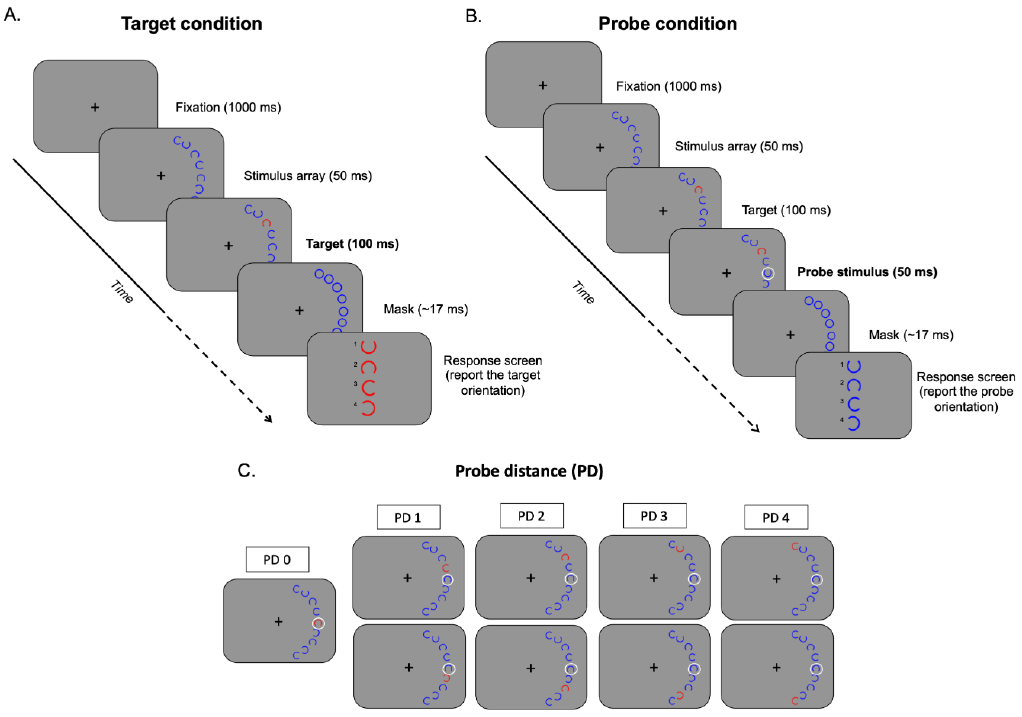
Figure 1. Schematic representation of the task procedure used to measure the spatial profile of the attentional focus in SSD. ( A ) Target condition. ( B ) Probe condition. ( C ) Determination of the different probe distances (PD) in the probe condition, where PD0 corresponds to the center of the attentional focus, while PD1 – PD4 represent positions progressively farther from the center of the focus.